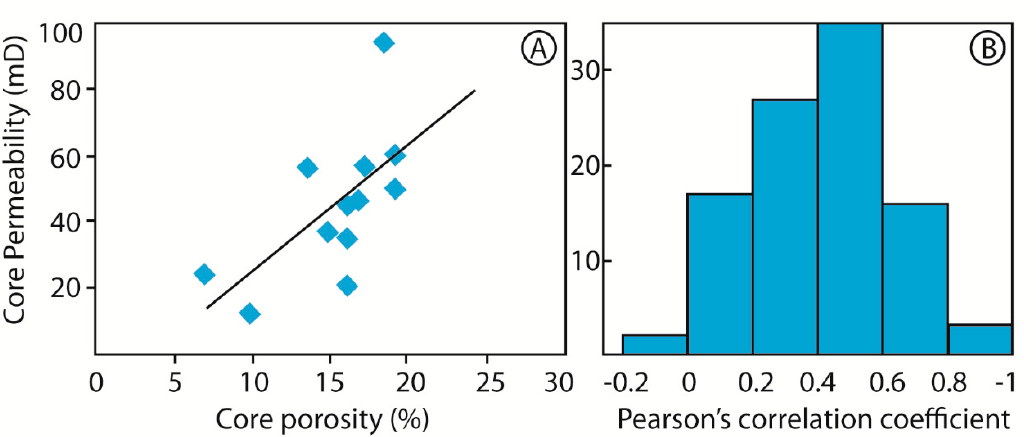
Figure 5. ( A ) Change of core permeability in relation to depth of Shahbazpur#2 sandstone samples; ( B ) histogram of bootstrapped Pearson’s correlation coefficient. Table 3. Core petrophysical parameters of Shahbazpur#2 well at different depths.